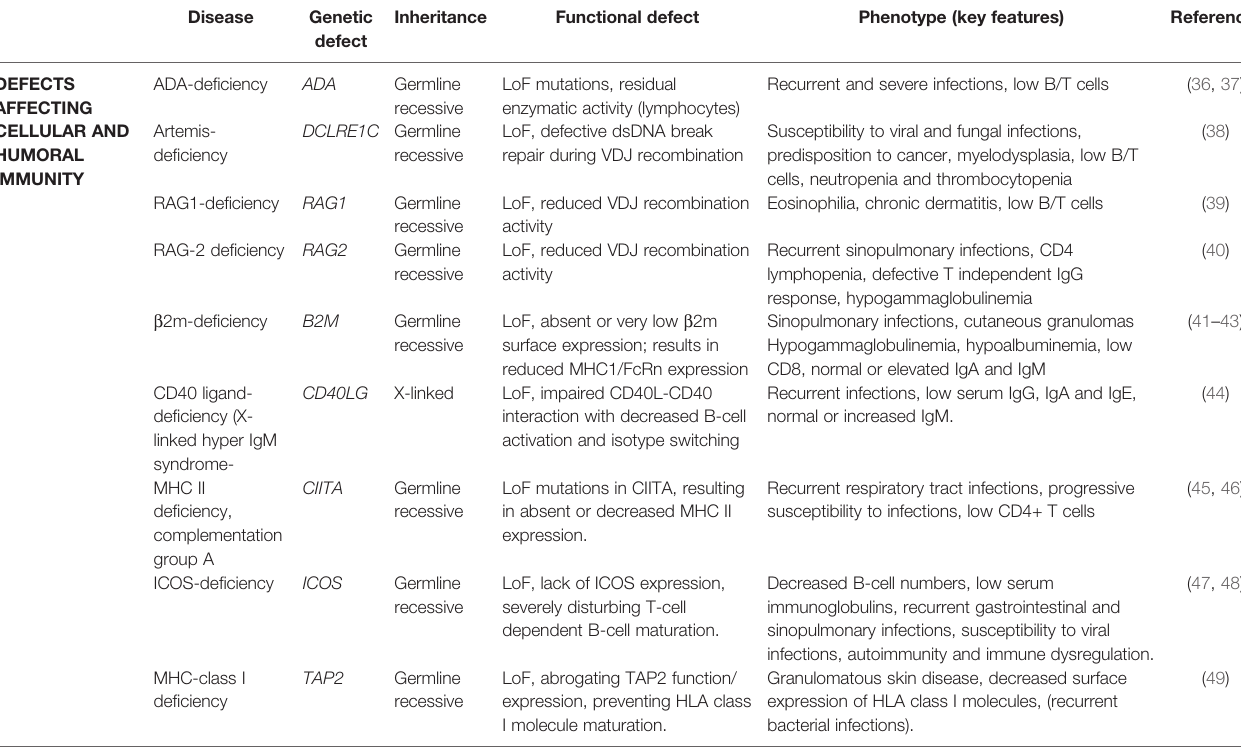
TABLE 2 | Genes associated with adult-onset combined immunode fi ciencies. Disease Genetic Inheritance Functional defect